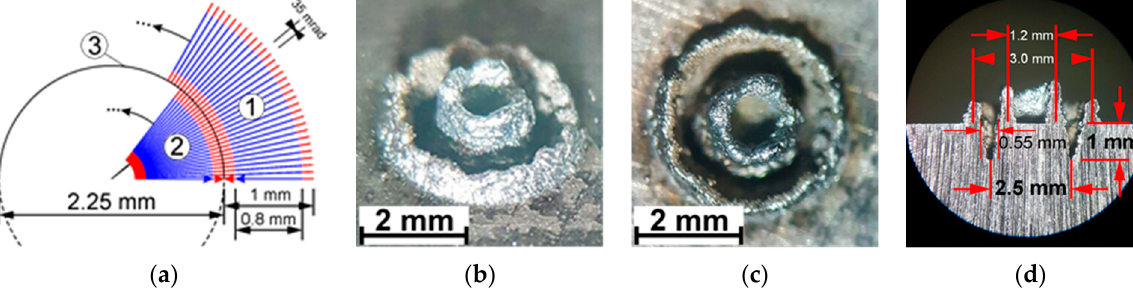
Figure 10. Scheme of the beam path over the surface of a metal plate ( a ), where ( 1 ) is the first set of vectors, ( 2 ) is the second set of vectors, ( 3 ) is an auxiliary circle, and external view of the annular groove from ( b ) the side, ( c ) top, and ( d ) cross-sectional view of the groove section with dimensions.